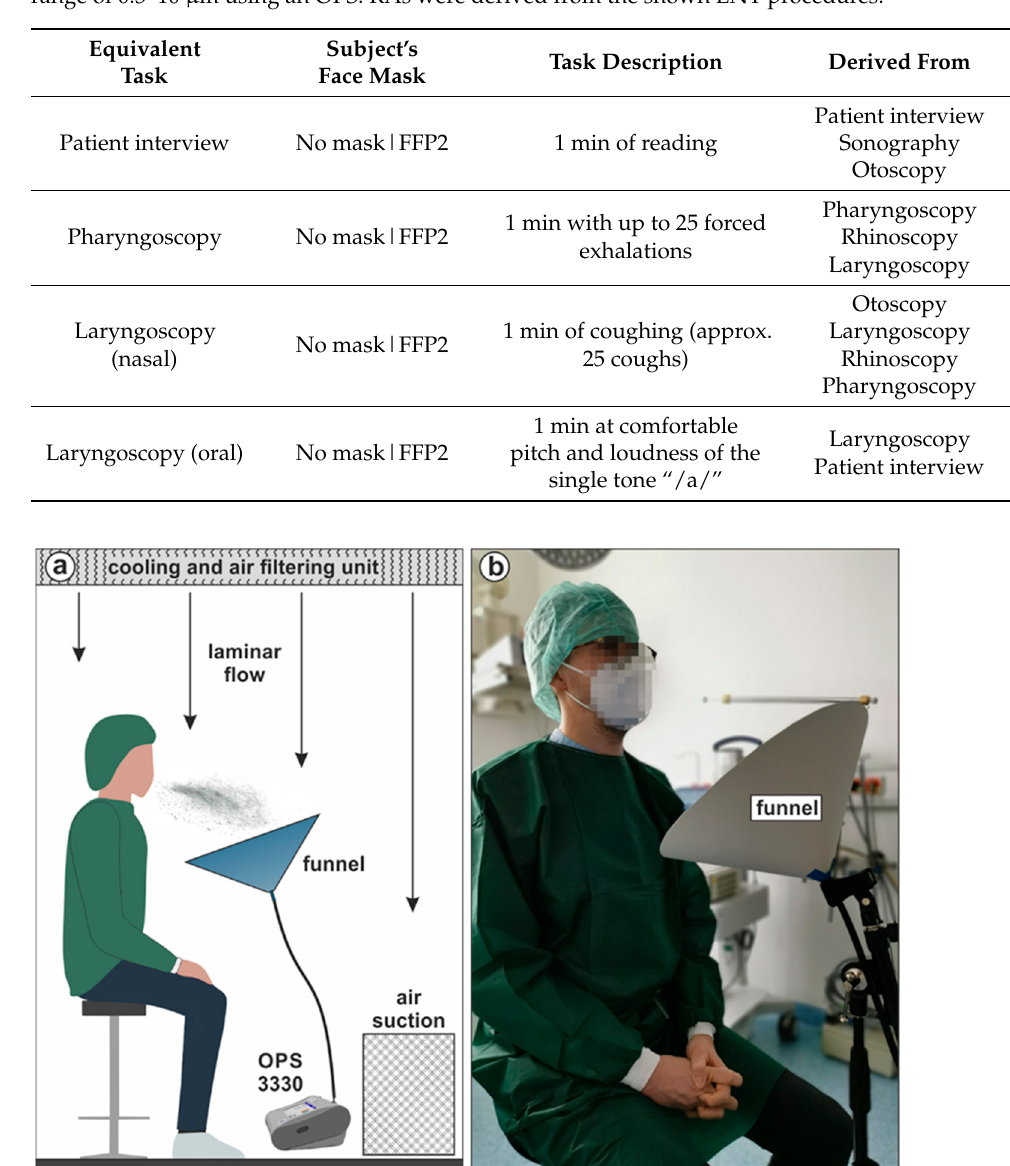
Table 2. Basic respiratory activities (RAs) analyzed with the aerosol particle test stand in the diameter range of 0.3–10 µ m using an OPS. RAs were derived from the shown ENT procedures.